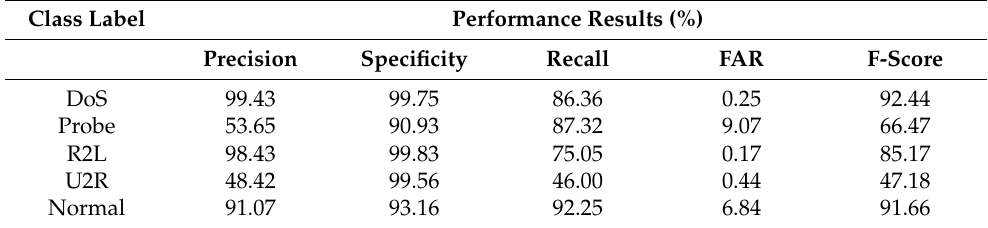
Table 6. Standard LSTM performance on NSL-KDDTest + using all 41